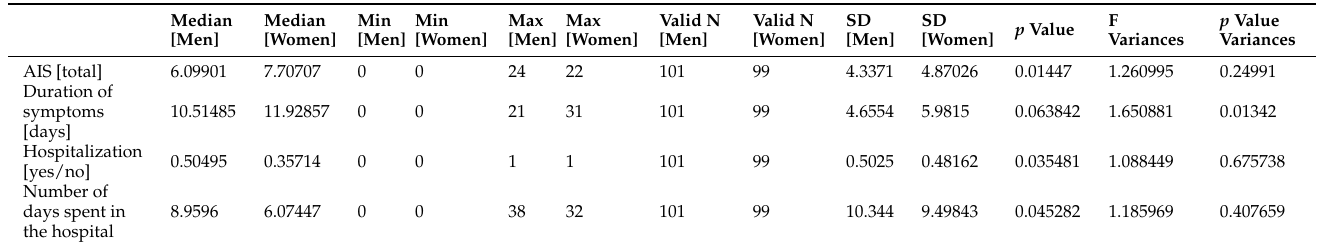
Table 1. Characteristics of the assessed parameters by gender.